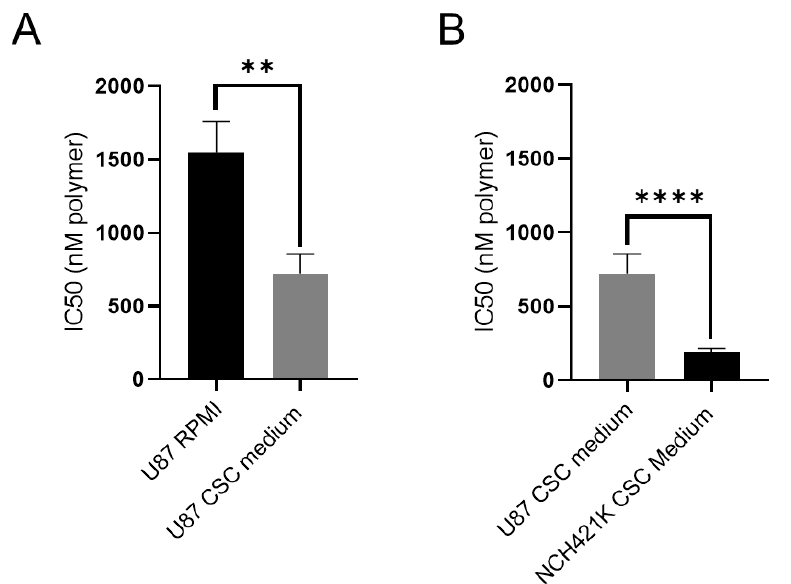
Figure 3. Effect of CSC medium on PEI toxicity on U87-MG cells. ( A ) Histograms showing 24 h IC50 values of PEI (expressed in nM of polymer) on U87-MG cells cultured in their standard medium (RPMI 10% FBS) vs. in serum-free CSC medium. ( B ) Histograms showing 24 h IC50 values of PEI (expressed in nM of polymer) on U87-MG cells cultured in CSC medium vs. NCH421K GSCs cultured in CSC medium. Values represent the mean of at least n = 3 independent experiments ± one SEM. Statistics represent Student’s T-tests. ** = p ≤ 0.01, **** = p ≤ 0.0001. Distribution normality was confirmed using a Shapiro–Wilk test.